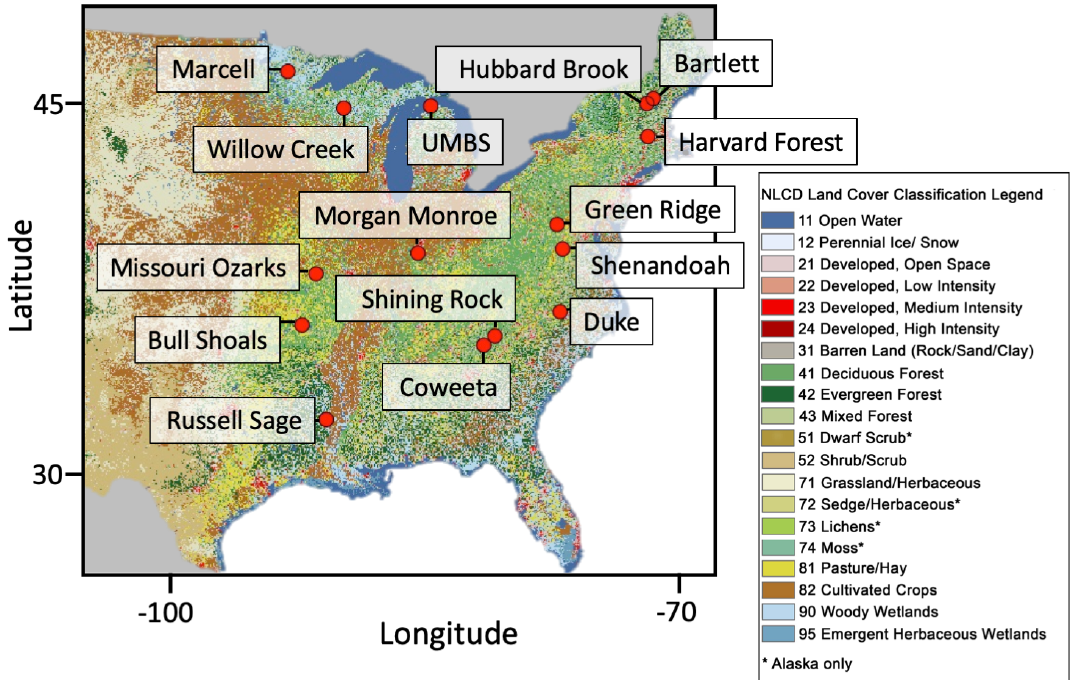
Figure 1. Map of 2016 National Land Cover Database (NLCD) classification (Jin et al., 2019; Yang et al., 2018) for the study region showing the locations of the selected sites. Selected sites are located throughout the deciduous forested area in the United States. Specific locations are given in Table 1.